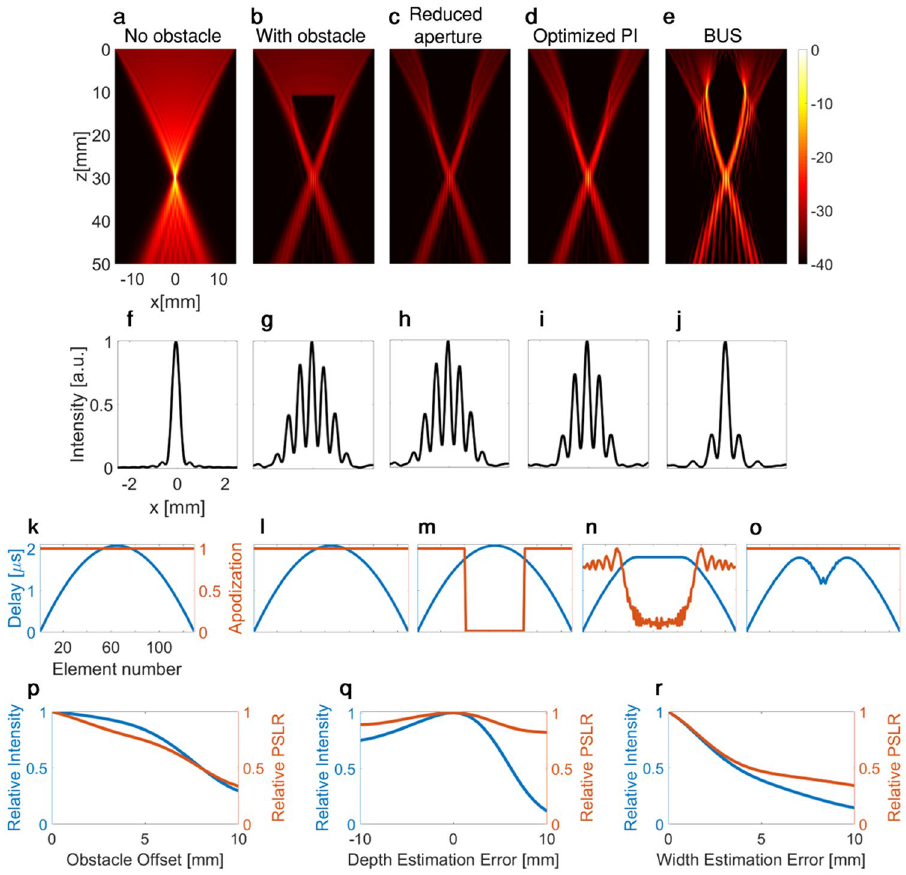
Figure 3. Comparison of the emitted acoustic intensity fields for the various imaging methods for a transducer aperture width (D) of 28.2 mm. Axes are common to ( a – e ),(f–j),(k–o). ( a – e ) are presented with a 40-dB dynamic range and a common colorbar ( a ) Emitted field for two-way focusing with focus at a depth of z = 30 mm (without the presence of an obstacle). ( b – e ) intensities are normalized with respect to ( a ). ( b ) Emitted field for two-way focusing focused at a depth of z = 30 mm, in the presence of a 10-mm diameter obstacle located at z = 10 mm. ( c ) Emitted field for two-way focusing where elements are turned off when the obstacle is in the direct path of the ray’s elements. ( d ) Optimized PI method. ( e ) BUS method designed to bypass the obstacle. ( f – j ) Lateral intensity profiles at the focus (z = 30 mm) for ( a – e ), respectively. ( k–o ) Delay (blue) and apodization (red) maps used for ( a–e ), respectively. ( p ) Effect of obstacle offset from the transducer center line on the focal intensity and peak-to- side-lobe ratio (PSLR). ( q ) Effect of depth estimation error on the focal intensity and PSLR. ( r ) Effect of width estimation error on the focal intensity and